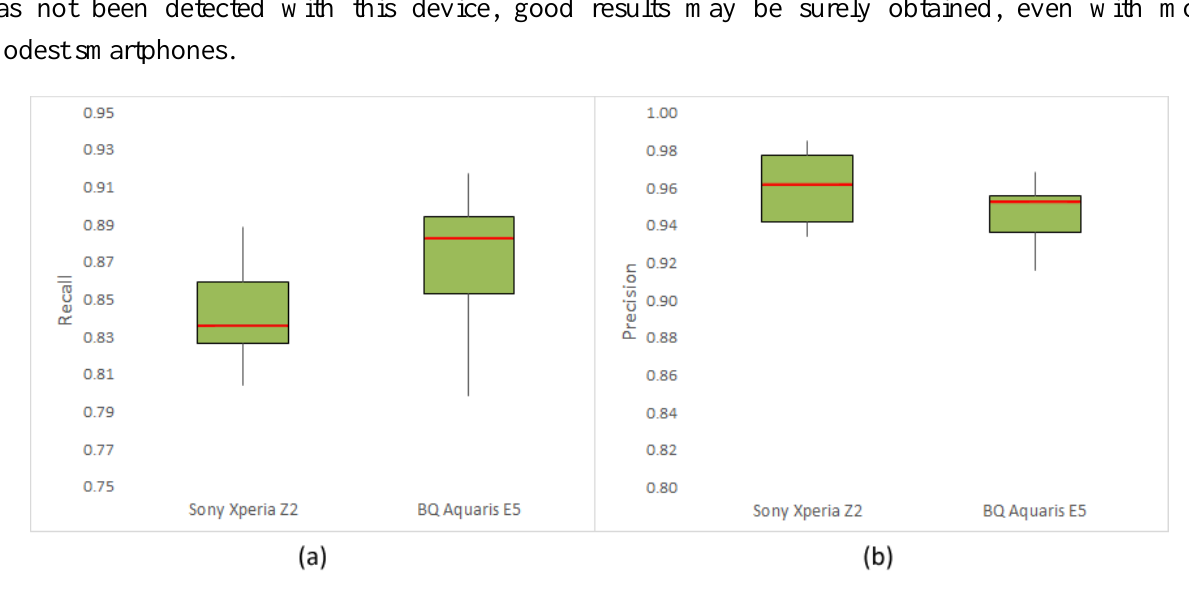
Figure 4. Box and whisker comparison plots for the Sony Xperia Z2 and the BQ Aquaris E5: ( a ) performance in terms of average Recall ( 𝑅𝐶̅̅̅̅ ); ( b ) performance comparison in terms of average Precision ( 𝑃𝑅̅̅̅̅ ).